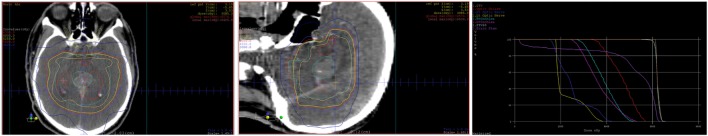
Axial and sagittal views of the dose distribution of the radiotherapy plan with the dose-volume histogram.